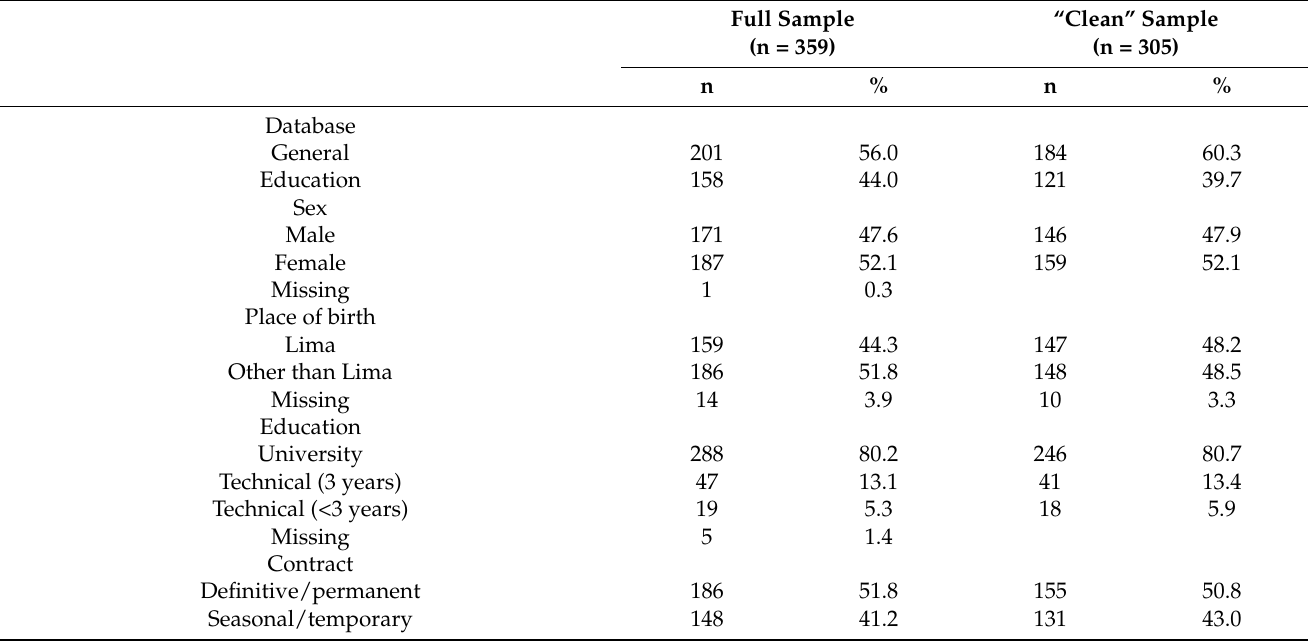
Table 1. Demographic and employment characteristics of participants (before and after data